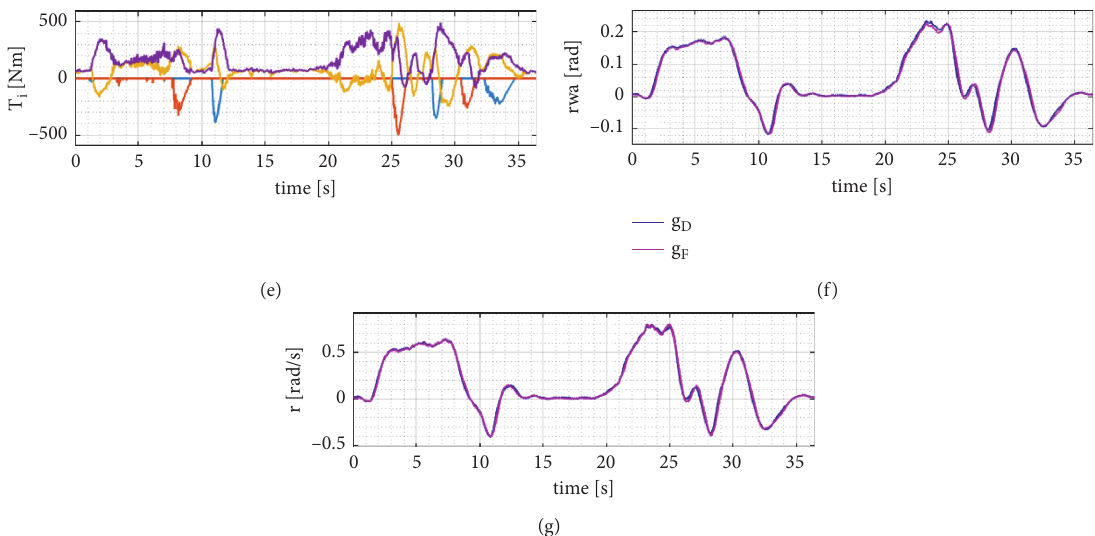
Figure 11: Comparison of the two cost function performing path-following. (a) Path. (b) Lateral error. (c) Longitudinal speed. (d) Wheel . (e) Wheel torques g . (f) Road-wheel angle. (g) Yaw rate. torques g D F